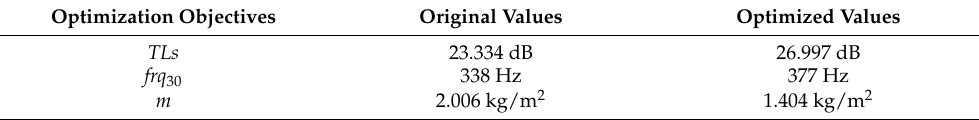
Table 3. Original and optimized optimization objective